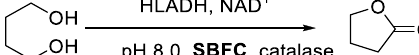
Table 1 Optimization of HLADH–SBFC